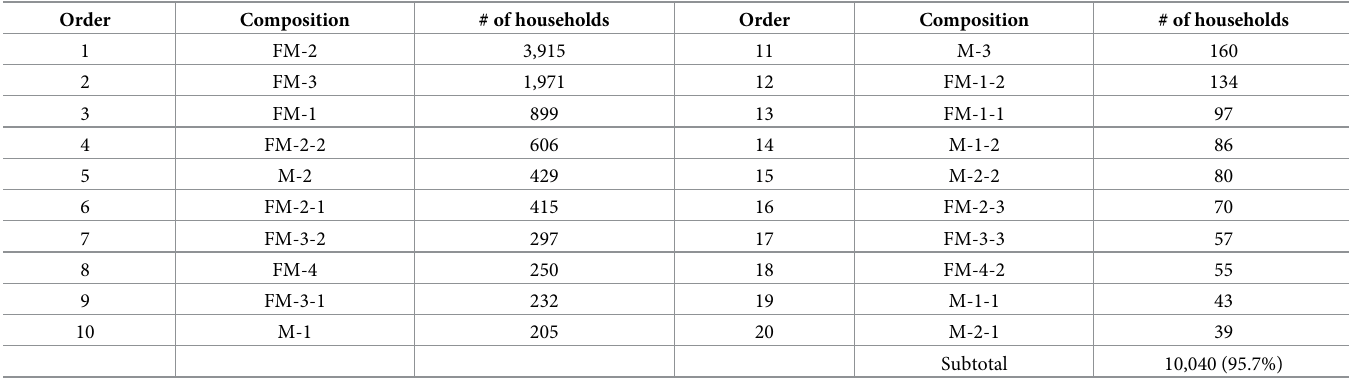
Table 2. Frequency distribution table for compositions of households included in the retrospective data.